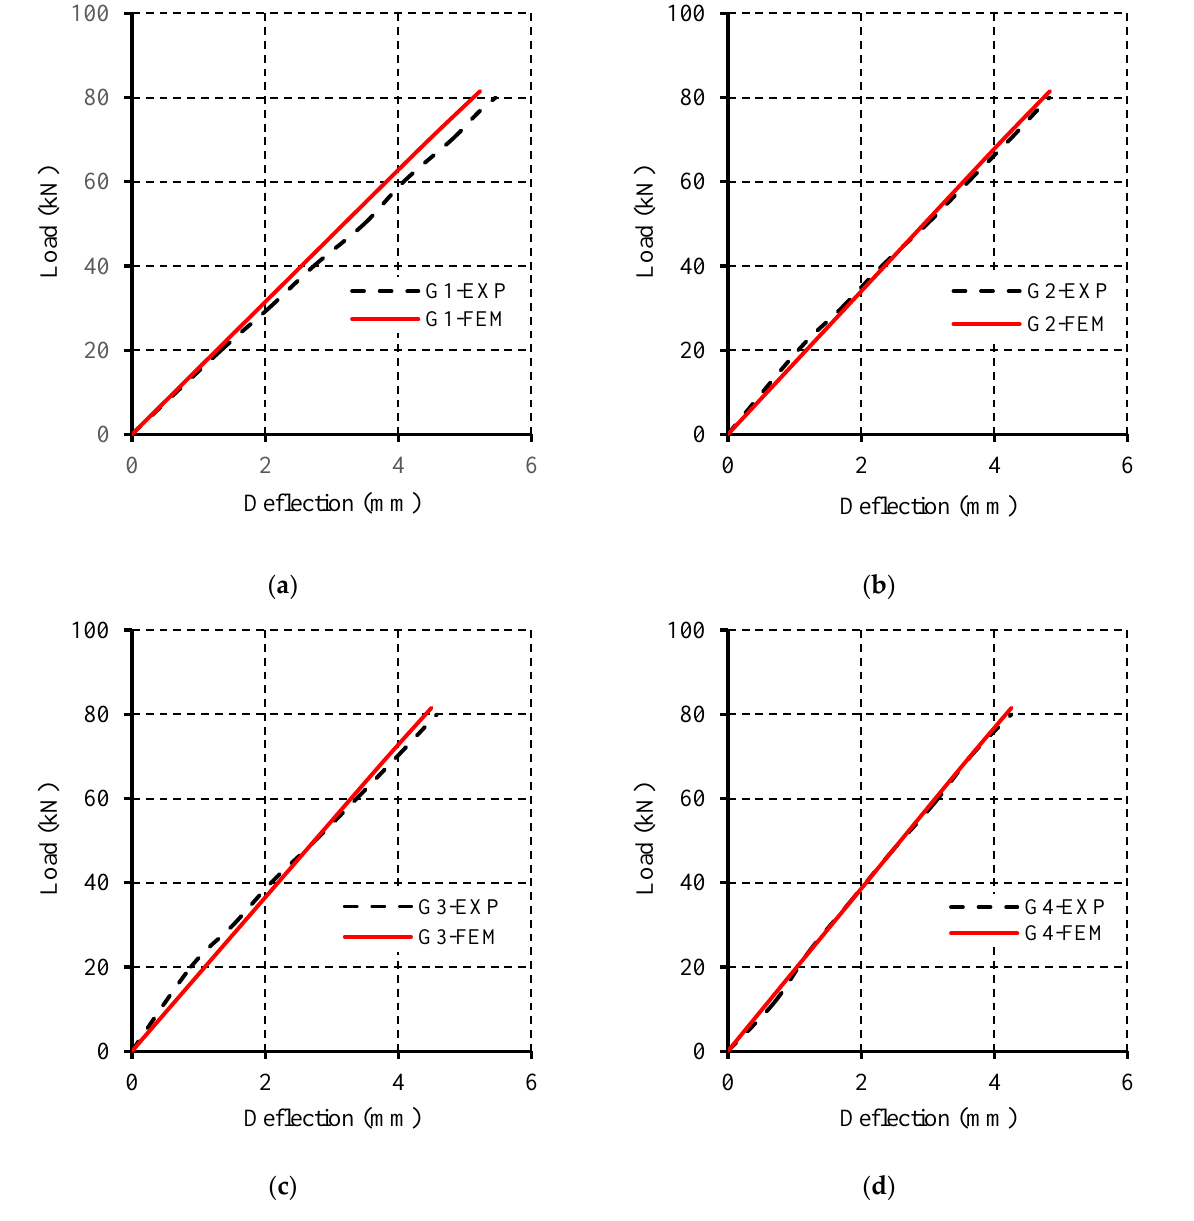
Figure 8. Validated load – deflection response of individual adjacent girders; ( a ) load – deflection response of girder G1, ( b ) load – deflection response of girder G2, ( c ) load – deflection response of girder G3, and ( d ) load – deflection response of girder G4.